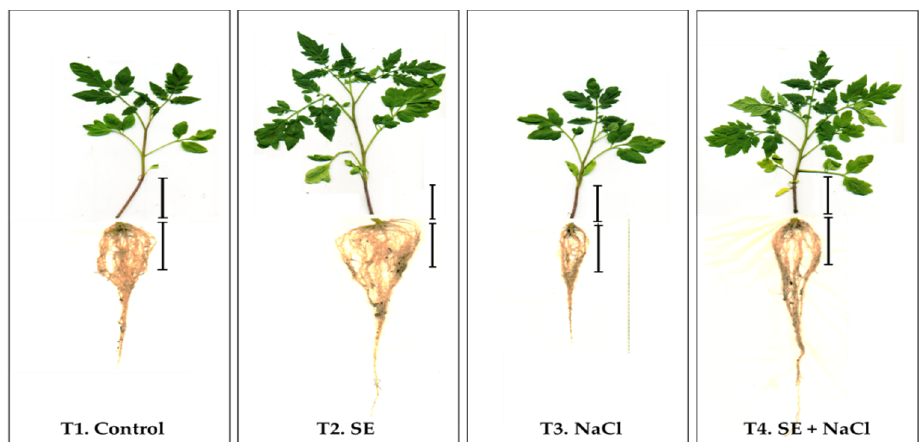
Figure 2. Tomato plant growth 46 days after germination (DAG). Treatments included T1 (Control plants grown under normal conditions), T2 (plants treated with the application of the P. gymnospora extract; 0.2% seaweed extract (SE)), T3 (plants grown under salinity stress conditions; 300 mM NaCl), and T4 (plants grown under salinity stress conditions (300 mM NaCl) and treated with the SE). Bar: 5 cm. Table 3. Growth parameters of the tomato plants.